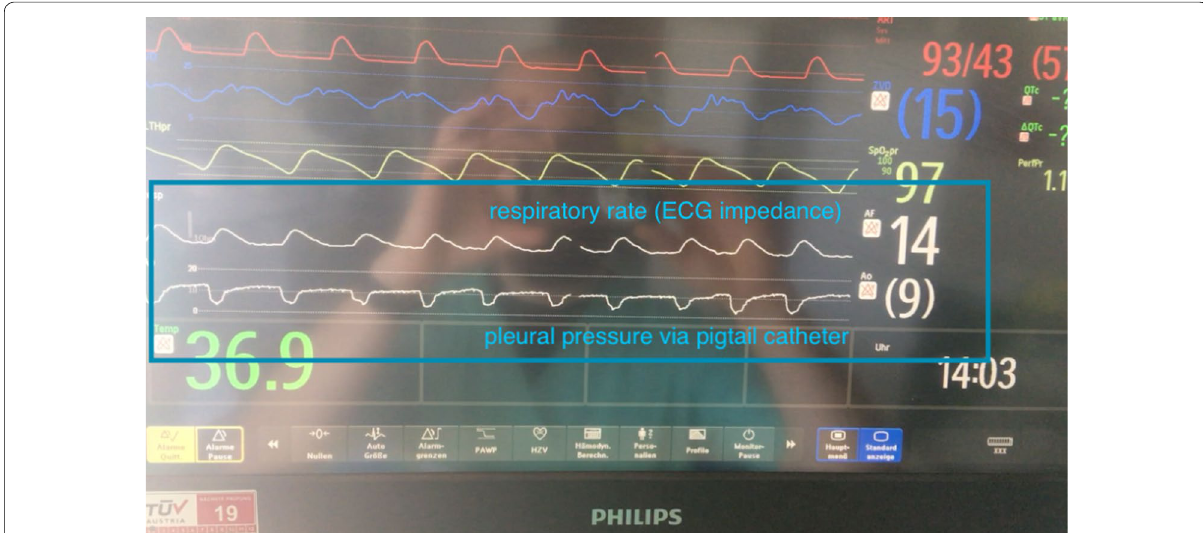
Fig. 1 Direct pleural manometry of an intubated, spontaneously breathing patient in an ICU